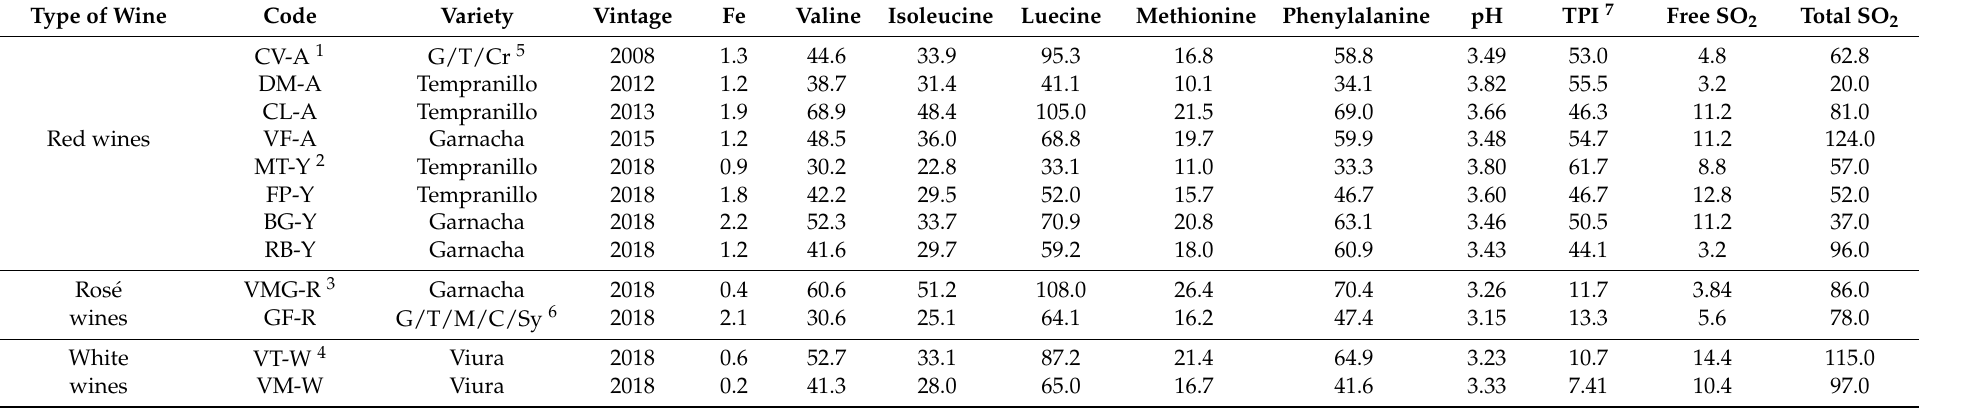
Table 1. Characteristics of the samples and some initial compositional parameters. Fe, Strecker amino acids, free SO 2 and Total SO 2 are expressed in